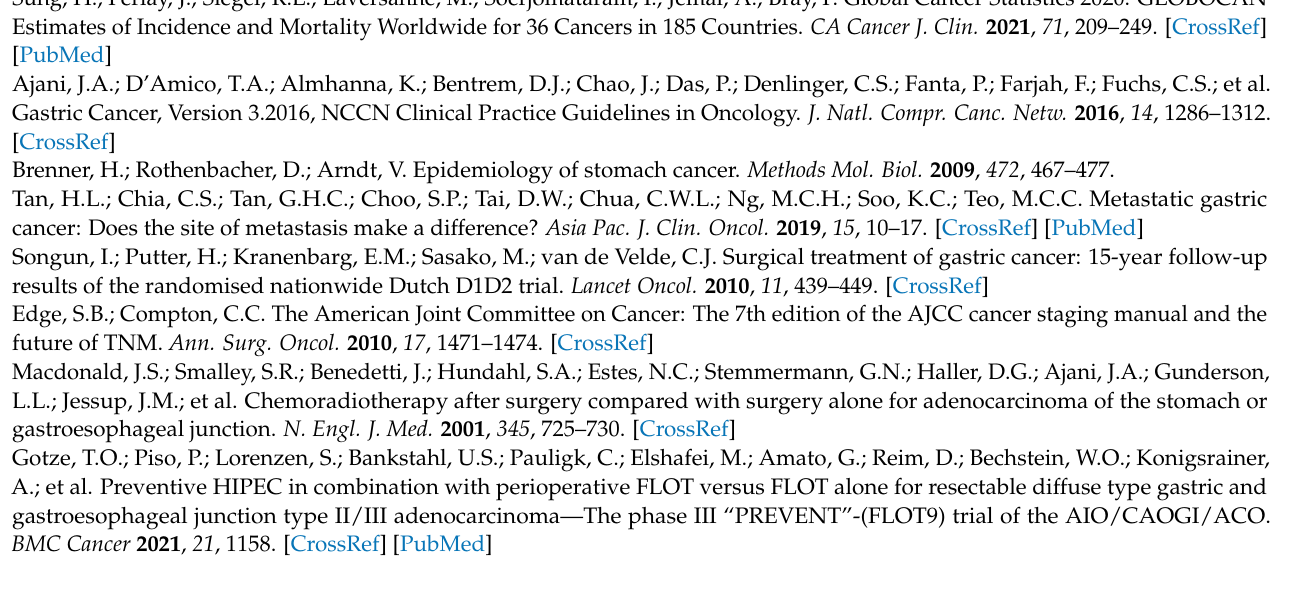
chart; Table S1: Univariate analysis of factors associated with mortality of patients with gastric cancer. Table S2: The Overall Survival of patients in the preoperative radiotherapy and postoperative radiotherapy groups (Stage-stratified survival